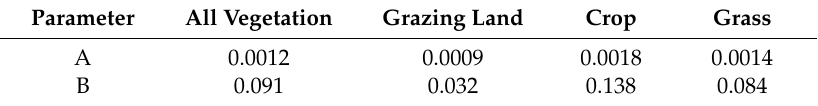
Table 3. The underlying vegetation parameters in a semi-empirical model. Parameter All Vegetation Grazing Land Crop